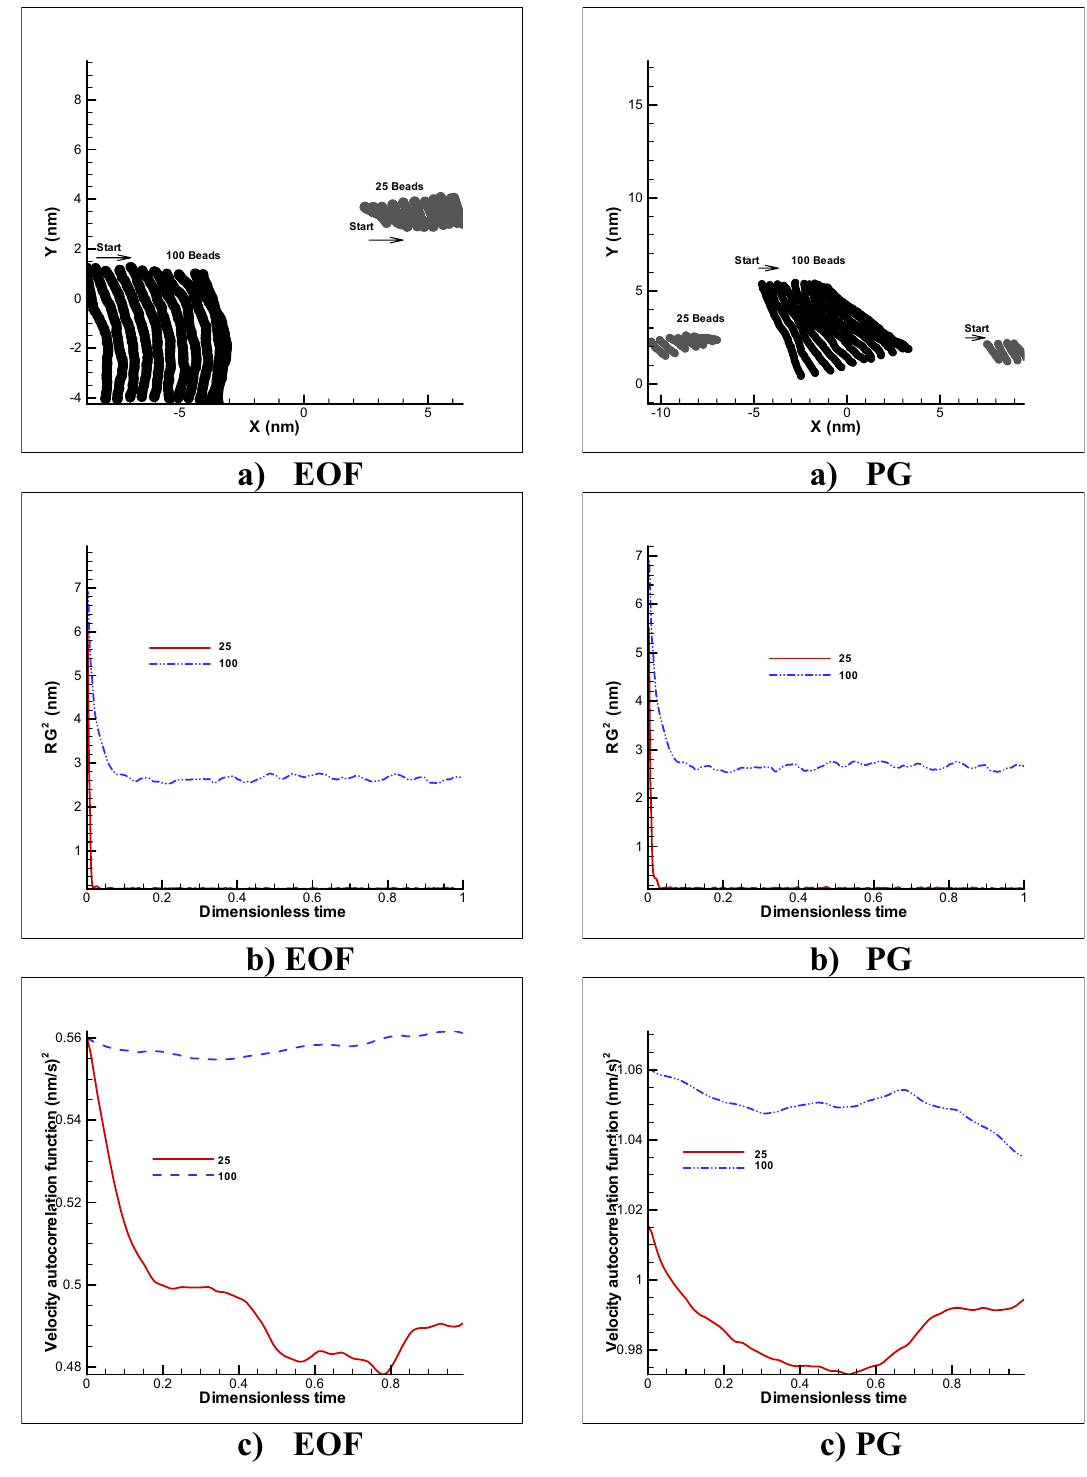
Figure 10. Free movement of a polymer chain in a simple channel ( a ), changes in gyration radius ( b ) and velocity correlation function ( c ) over time considering different n = 25 and n = 100 beads for both pressure gradient and electroosmotic flow test